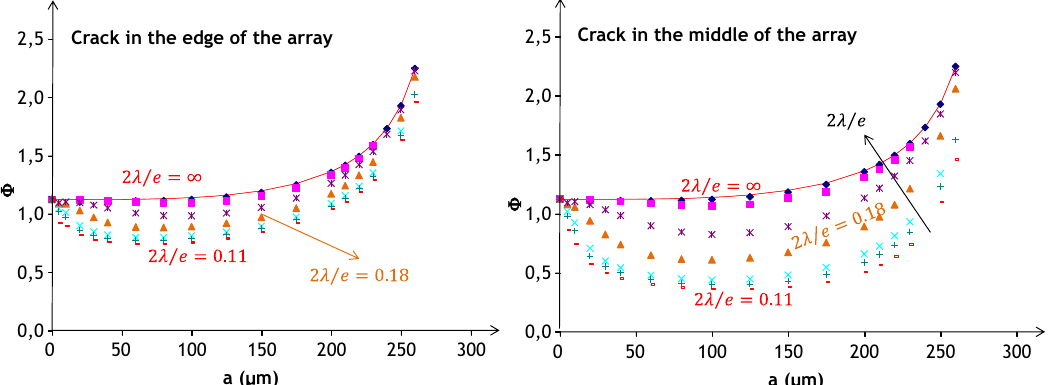
Fig. 7. Shape function values at the edge and at the middle location of the crack array (marks: calculated values; lines: correlated